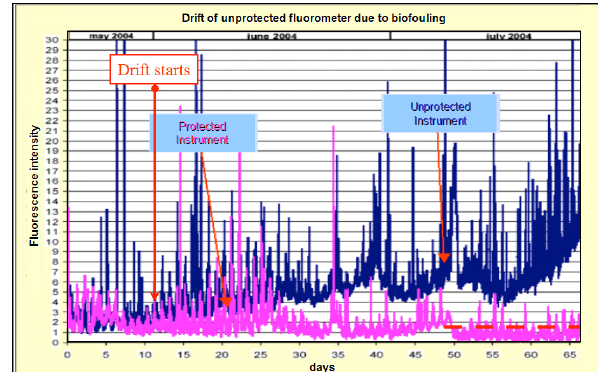
Table 1. Biofouling protection strategies for oceanographic